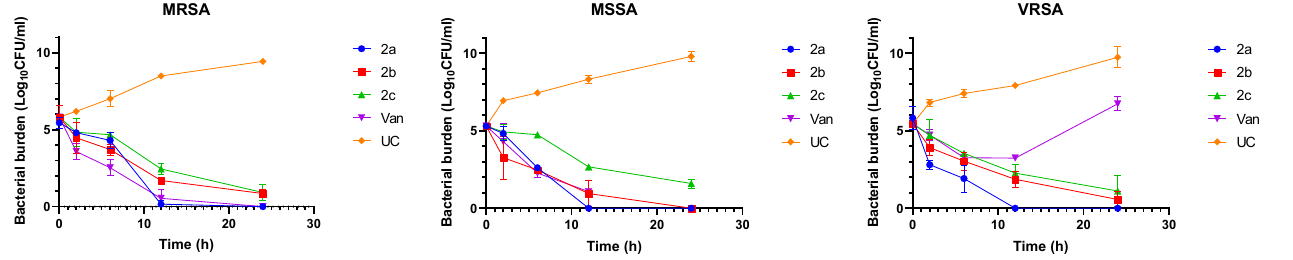
Figure 2. The in vitro time-kill studies of most potent compounds 2a – c against Staphylococcus aureus harboring genetically defined resistance mechanisms. The representative S. aureus strains (MRSA, MSSA, VRSA) were exposed at MIC concentration of compounds 2a – c or vancomycin for 24 h. The viable bacterial numbers in treatment groups or untreated control (UC) were calculated after dilution and plating. Data provided in the graphs are mean ± SD from 3 experimental replicas.